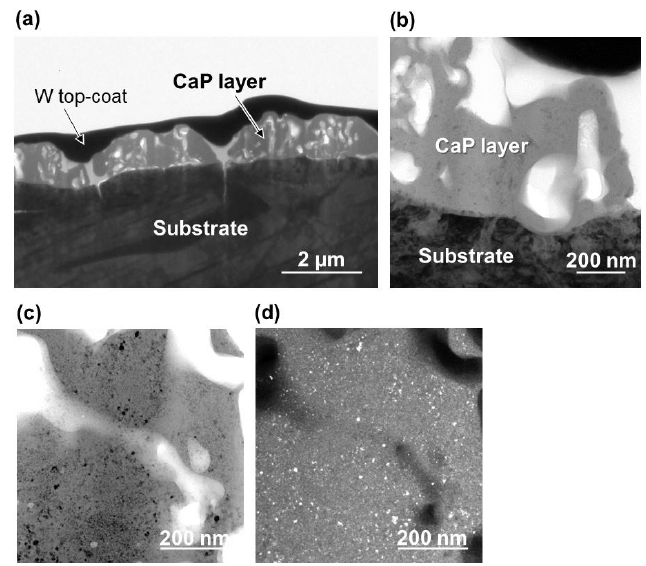
Figure 6. ( a – c ) Bright-field and ( d ) dark-field transmission electron microscopy (TEM) images of the ultra-thin cross-section of the CaP layer formed on the LAB-processed (30 min) Co−Cr alloy substrate. The W top coat in ( a ) was prepared during focused ion beam (FIB) processing. The image in ( c ) corresponds to that in ( d